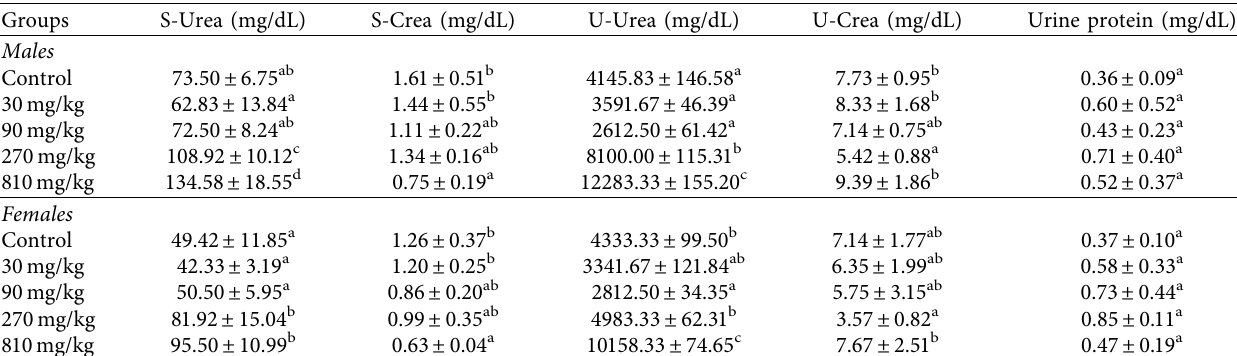
Table 6: Effect of aqueous extract of T. grandis leaves on kidney function markers of